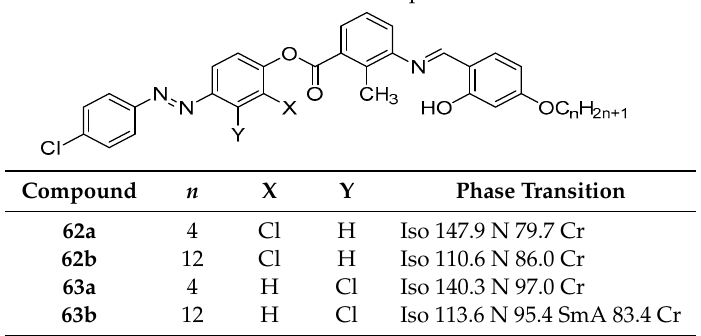
Table 12. Phase transition of compounds 62 and 63 .